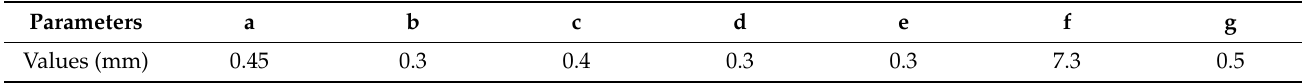
Table 2. The Lumped Parameters for the Equivalent Circuits.